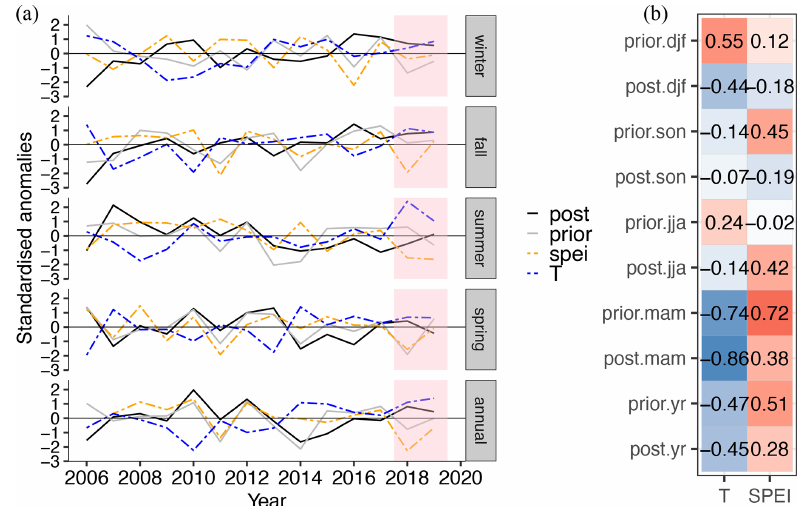
Figure 9. Panel (a) shows the anomalies of posterior NEE (post), prior NEE (prior), SPEI (spei), and 2m air temperature ( T ) standardised relative to the standard deviation of climatological variations at annual and seasonal scales since 2006 over the full domain of Europe. Units of NEE and temperature are in PgCyr − 1 and K, respectively, while SPEI is unitless. Panel (b) refers to the correlation coefficients of posterior and prior NEE on the y axis with SPEI and air temperature on the x axis calculated in springs (mam), summers (jja), falls (son), and winters (djf) and at annual scales (yr) over the full domain of Europe. Note: seasonal T and SPEI correspond to NEE seasons mentioned on the y axis.